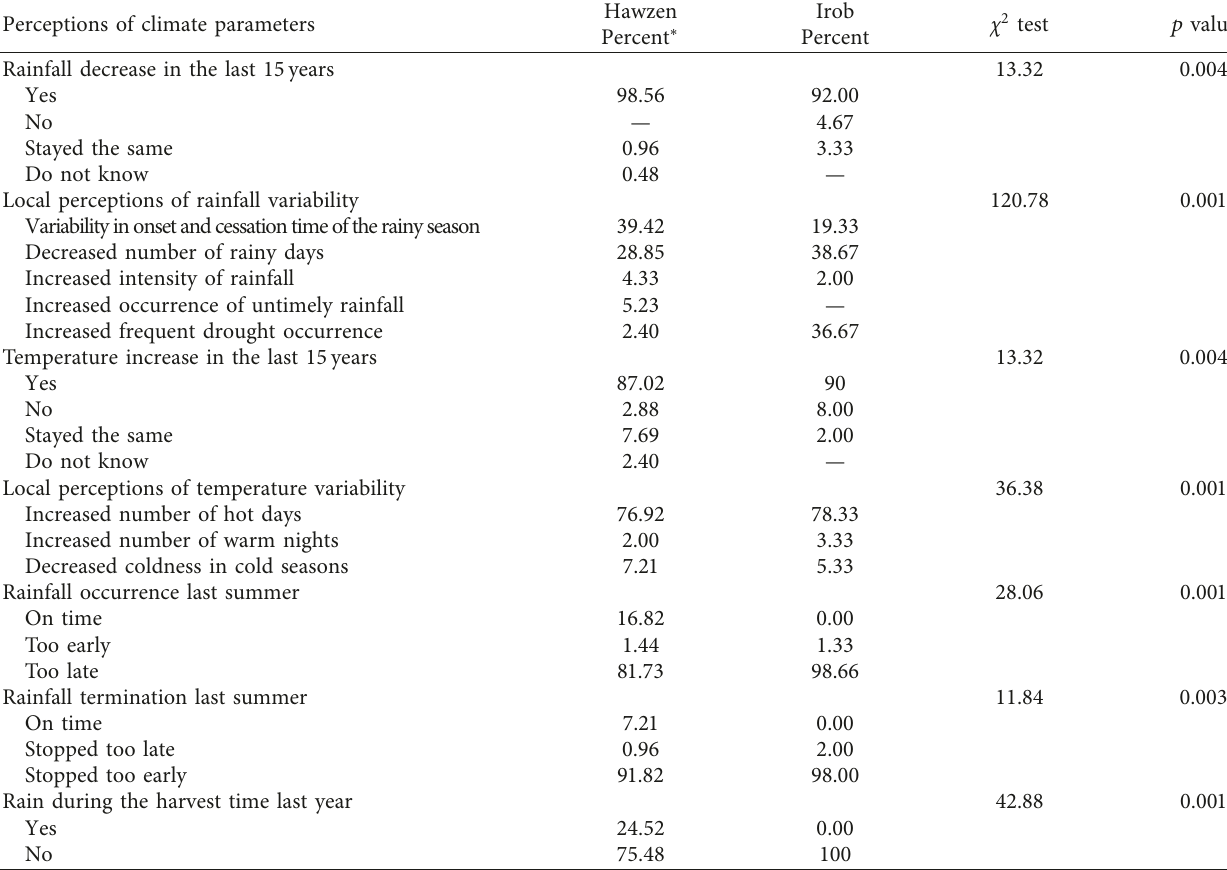
Table 2: Farmers’ perception of climate change and climate shocks ( n �